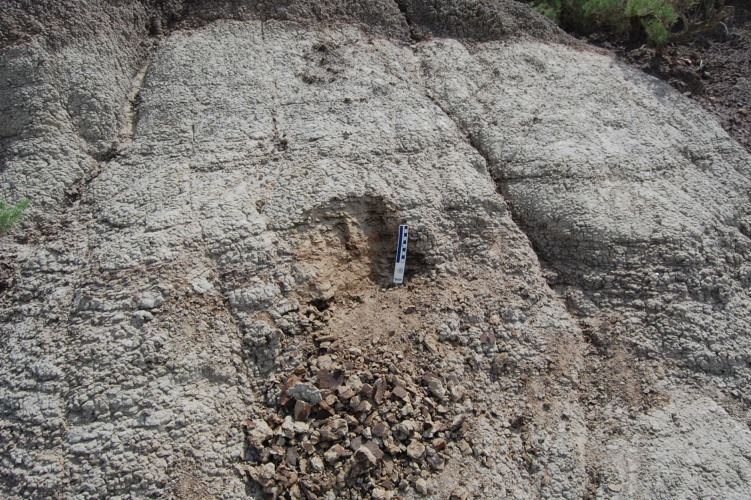
Mudstone collected from 709 m elevation after sampling.